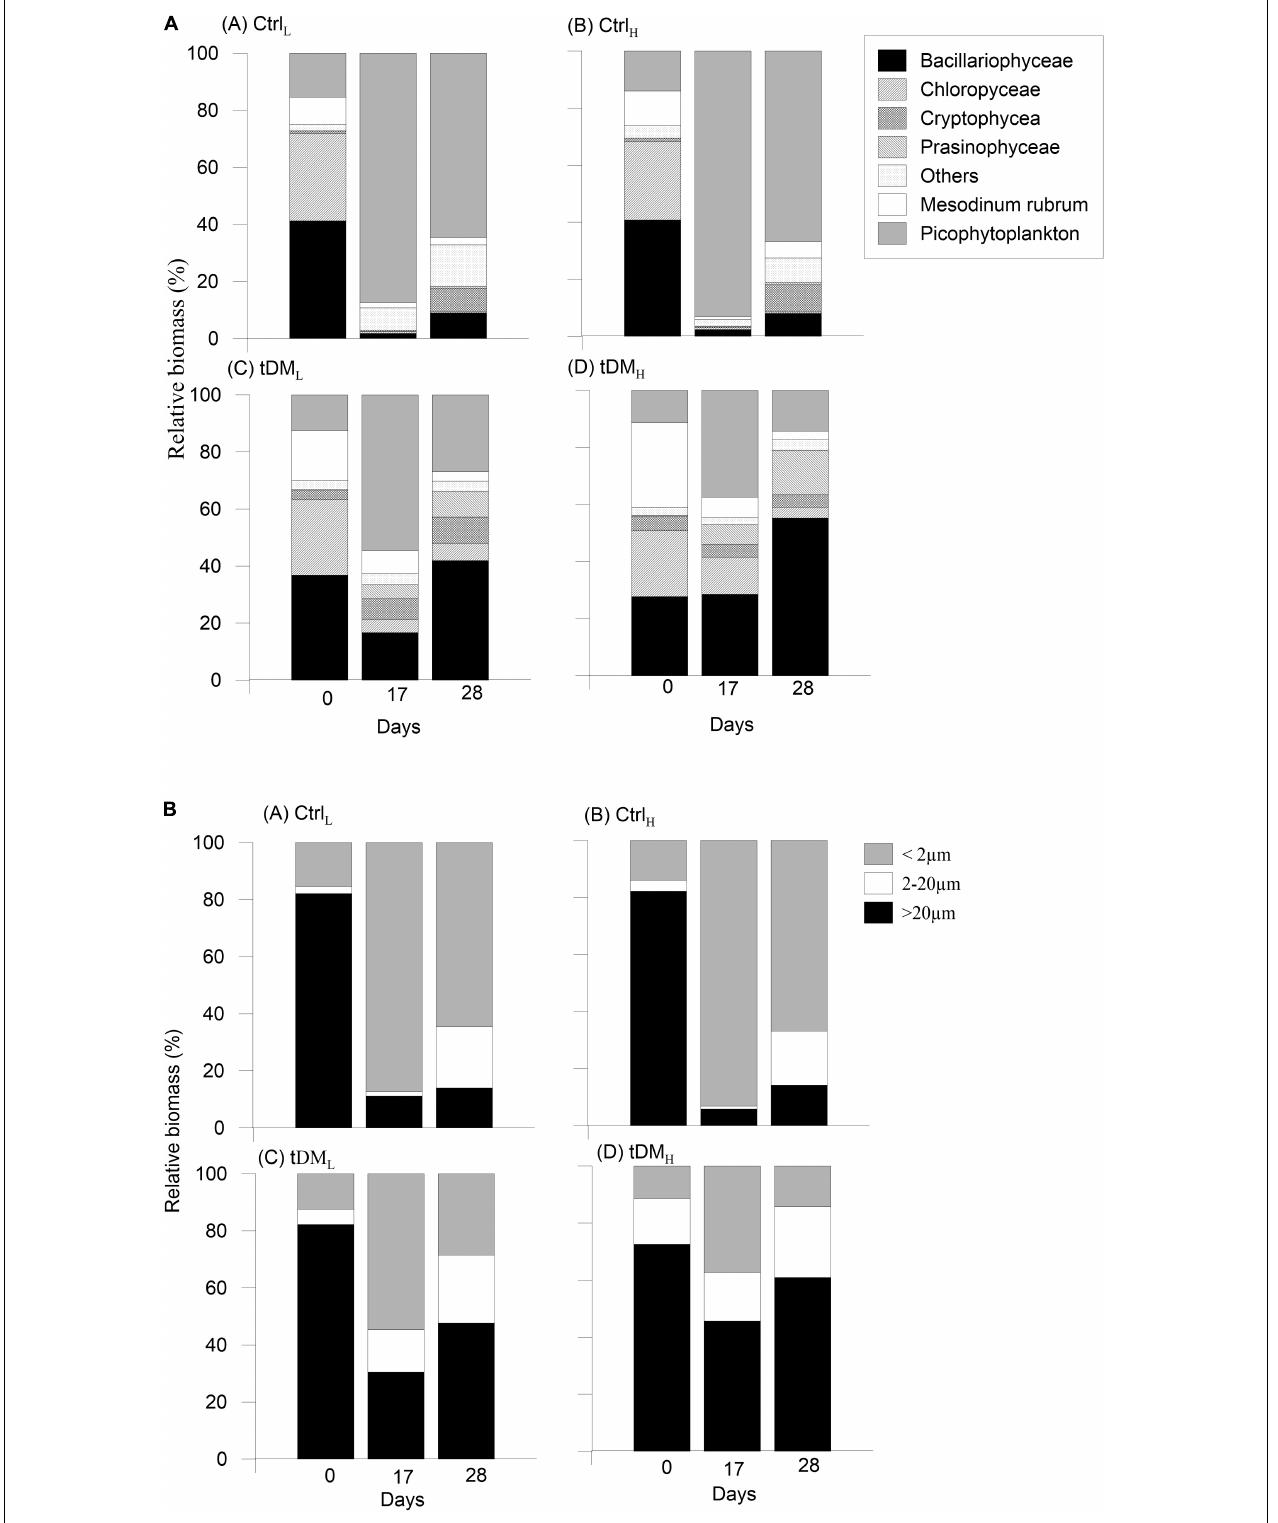
FIGURE 3 | Phytoplankton taxonomic composition and size-structure at the start, middle and end of the experiment: biomass distribution of major phytoplankton taxa: Bacillariophyceae, Chlorophyceae, Cryptophyceae, Prasinophyceae, Others, Mesodinum rubrum and picophytoplankton (A) , and biomass distribution of size-classes: pico- ( < 2 µ m), nano- (2–20 µ m), and microphytoplankton ( > 20 µ m) (B) .